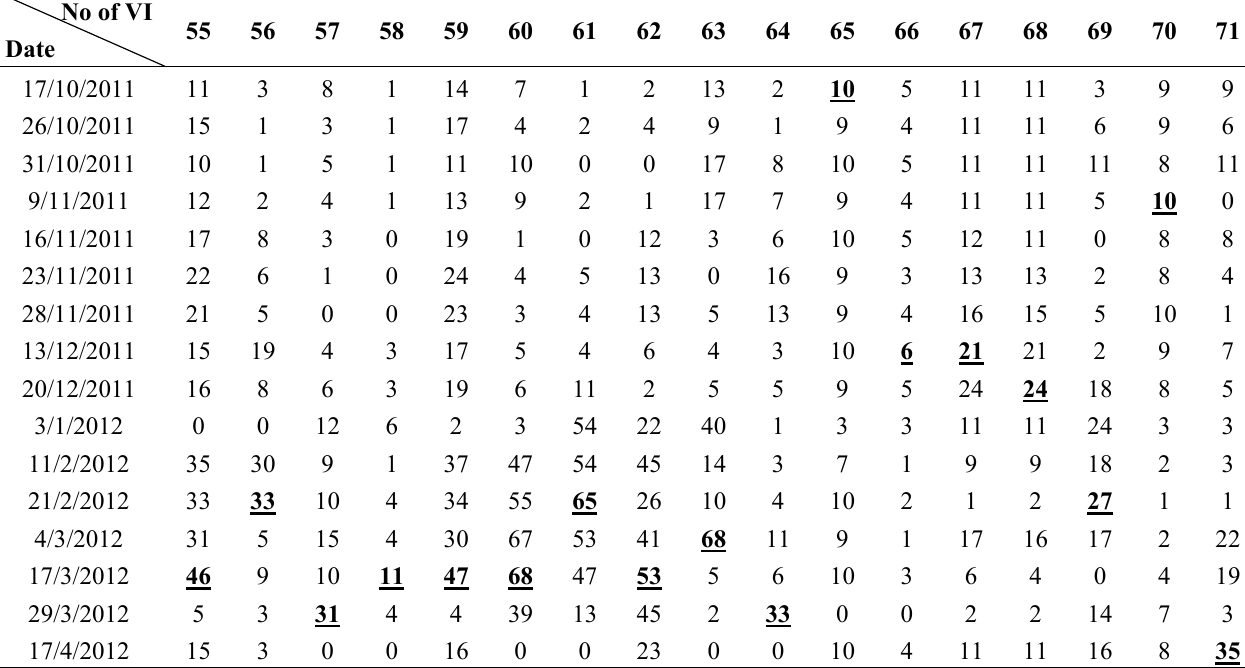
Table 5. VI performance for each narrowband index (55–71 see Table 1) calculated for each field campaign. The higher values for each index are